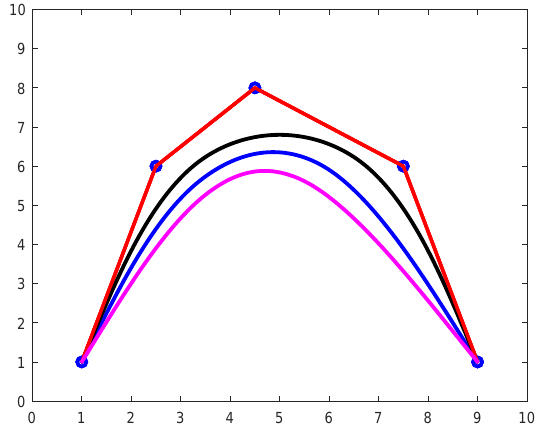
Figure 15. Open rational B-spline curve.